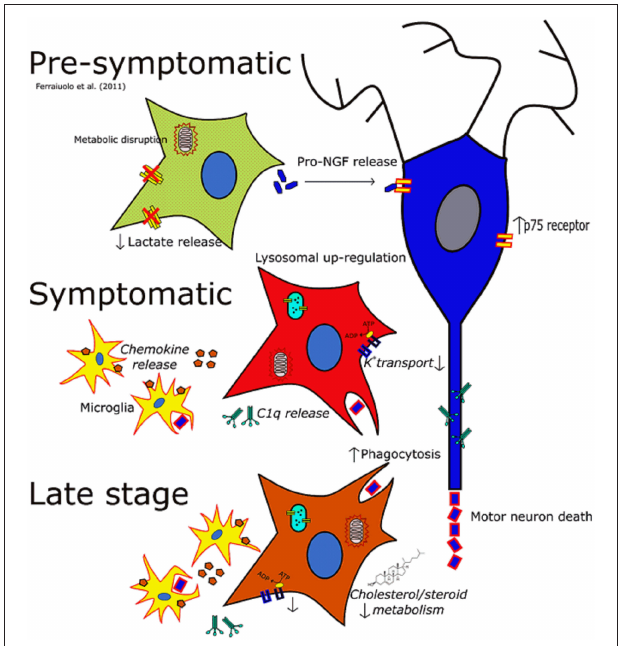
FIGURE 5 | The changing phenotype of astrocytes during the disease course in the SOD1 G93A mouse. Italics indicate data inferred from microarrays whilst non-italics indicate data for which functional outcomes have been observed. At the pre-symptomatic stage astrocyte gene expression is characterized by disruptions in lactate provision to neurons and mitochondrial dysfunction, as well as perturbations in secreted trophic factors such as the pro-NGF:NGF ratio. At the symptomatic time-point astrocytes take on a much more reactive phenotype characterized by increased lysosomal, phagocytic and chemokine gene expression whilst also featuring a down-regulation of genes involved in potassium transport. At late-stage disease astrocytes feature differential expression of a large number of genes, and still show the disruption seen at the symptomatic stage. In addition cholesterol synthesis transcripts are differentially expressed at this time-point which may indicate an excess of cholesterol in the CNS, or a disruption in the activation of cholesterol